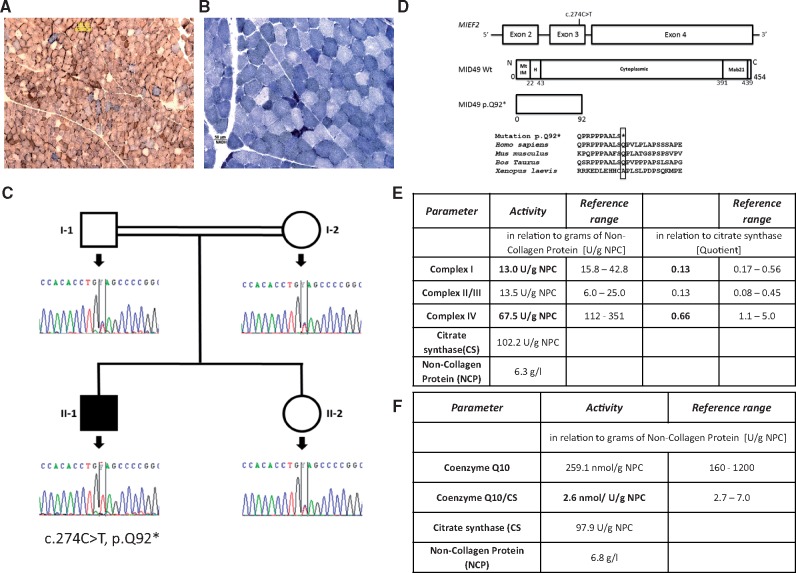
Diagnostic testing of respiratory chain function in skeletal muscle and genetic studies. (A) Simultaneous staining of muscle fibres for cytochrome oxidase (COX) and succinate dehydrogenase (SDH), (B) Nicotinamide adenine dinucleotide (NADH) staining of muscle fibres. Dark blue muscle fibres represent increased mitochondrial proliferation, pale muscle fibres illustrate deficient muscle fibres. (C) Pedigree diagram and Sanger sequencing results showing the segregation of the MIEF2 c.274C>T, p.Q92* mutation. (D) Schematic showing MIEF2 gene structure, MID49 wildtype protein structure [domains represented as follows: Mitochondrial Intermembrane (MtIM), Helical (H), Cytoplasmic and Mab21] and MID49 mutant p.Q92* structure including conservational analyses of the amino acid among species. (E) Biochemical measurement of respiratory chain enzymes. (F) Coenzyme Q10 in the muscle biopsy of the patient. Abnormal values are marked in bold.